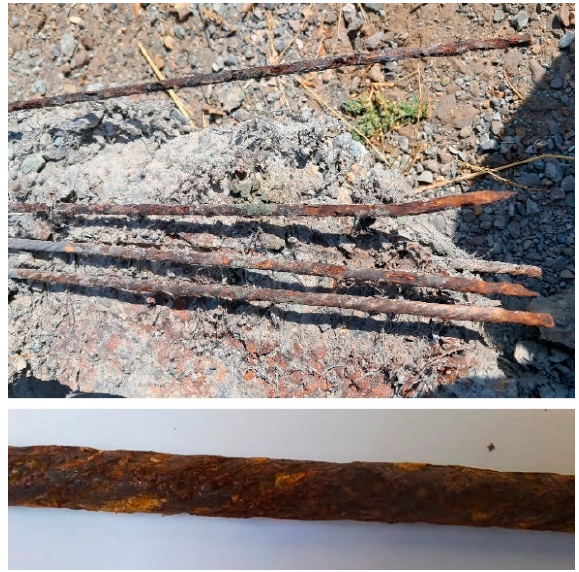
Materials 2023 , 16 , 1629